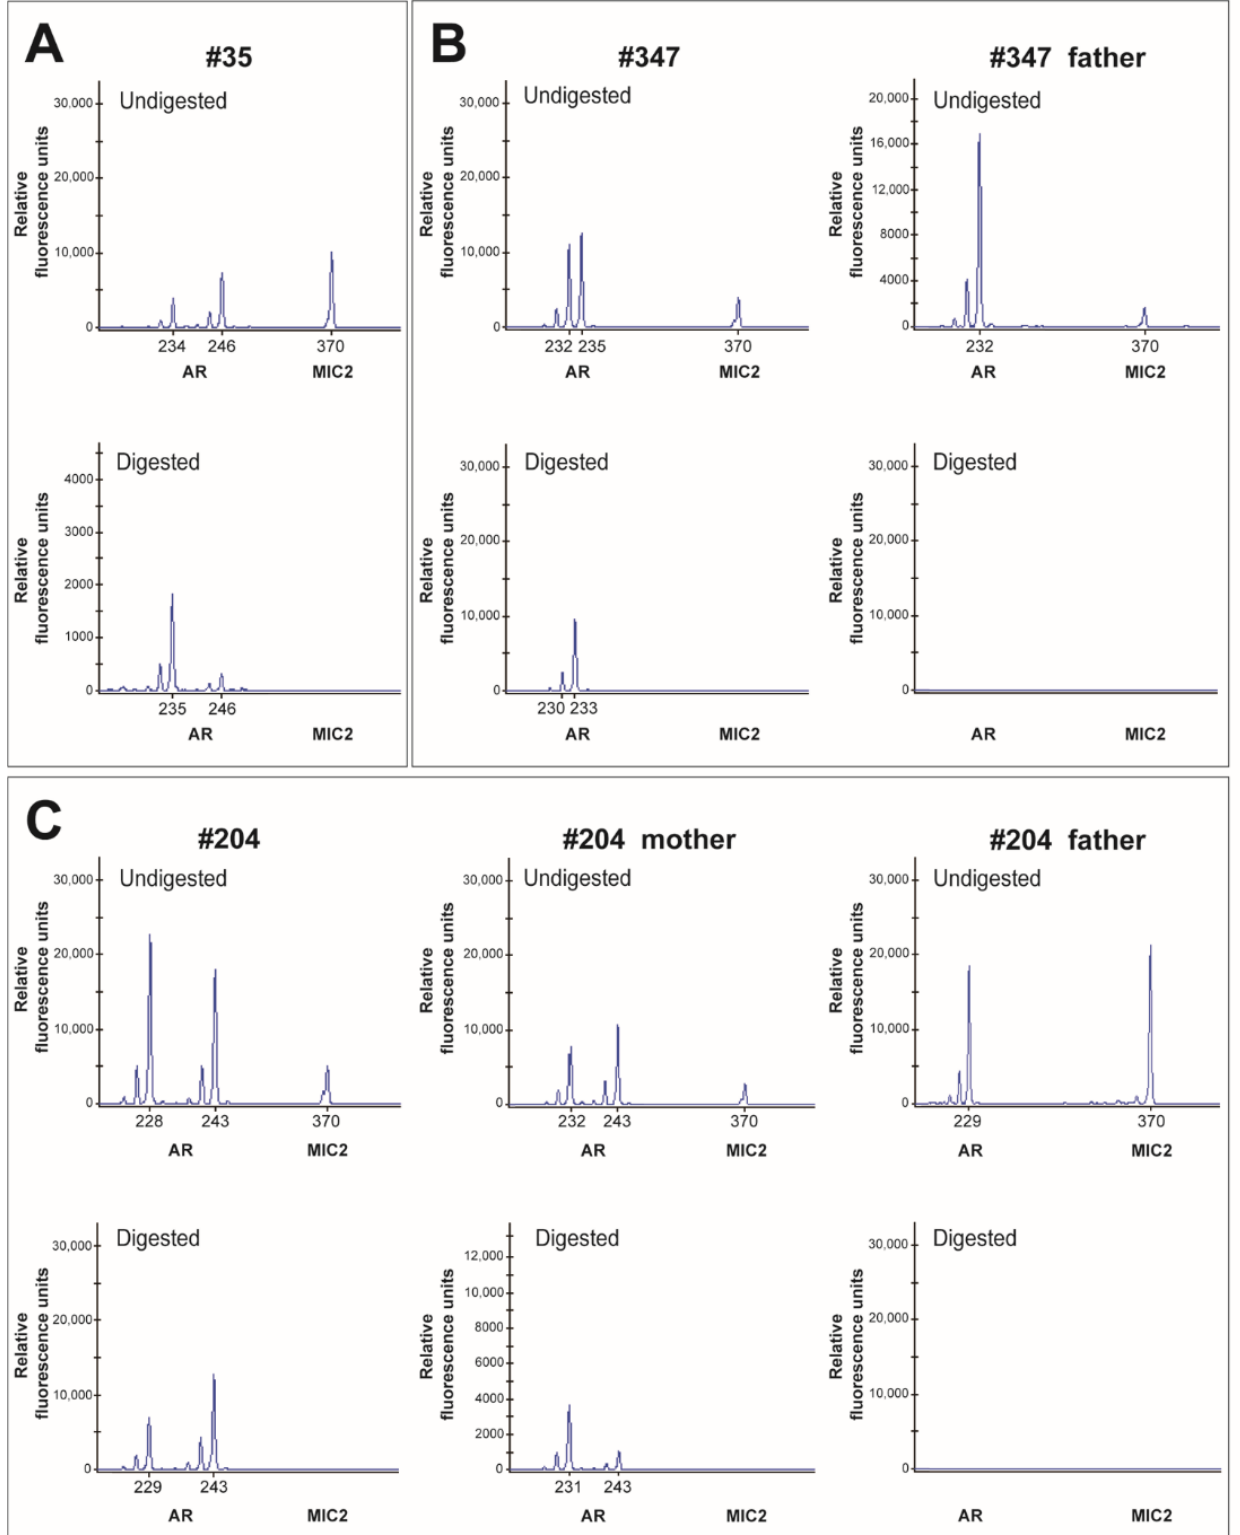
Figure 4. Skew of the X-chromosome inactivation (XCI) analysis. ( A ) The capillary electrophoresis results of patient #35. ( B ) The capillary electrophoresis results of patient #347 and her father. ( C ) The capillary electrophoresis results of patient #204 and her parents.